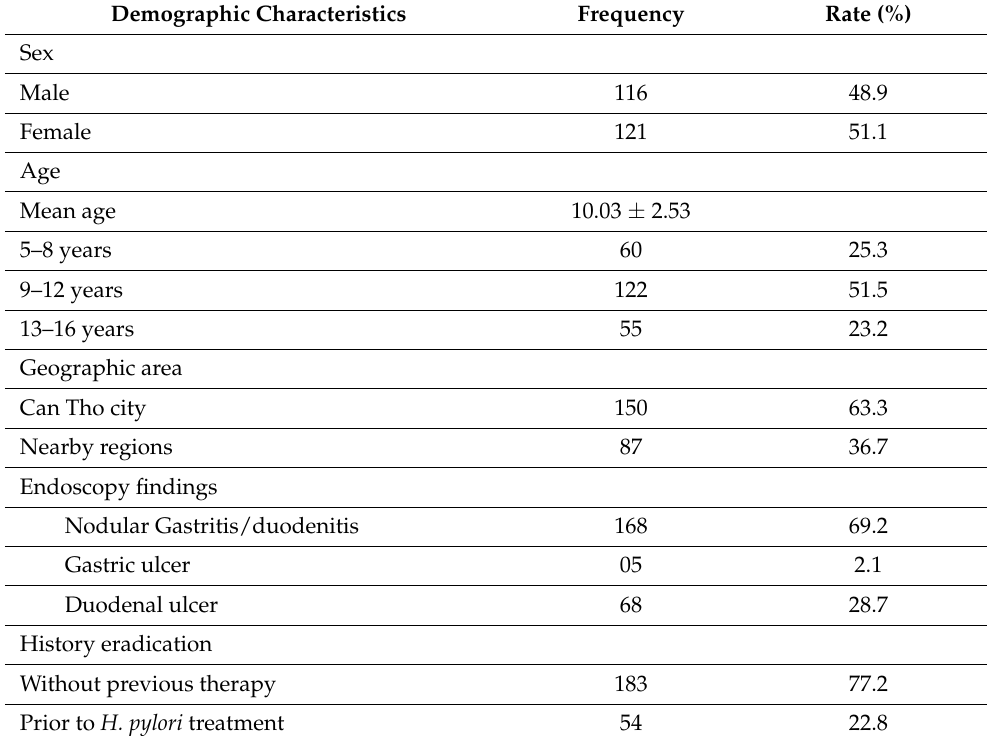
Table 1. Patient characteristics ( n = 237).